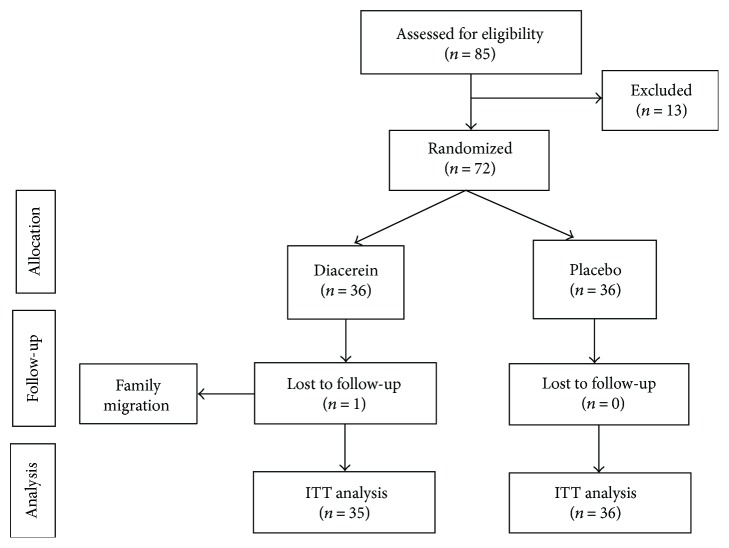
Flow diagram of participant selection, randomization, and follow-up.